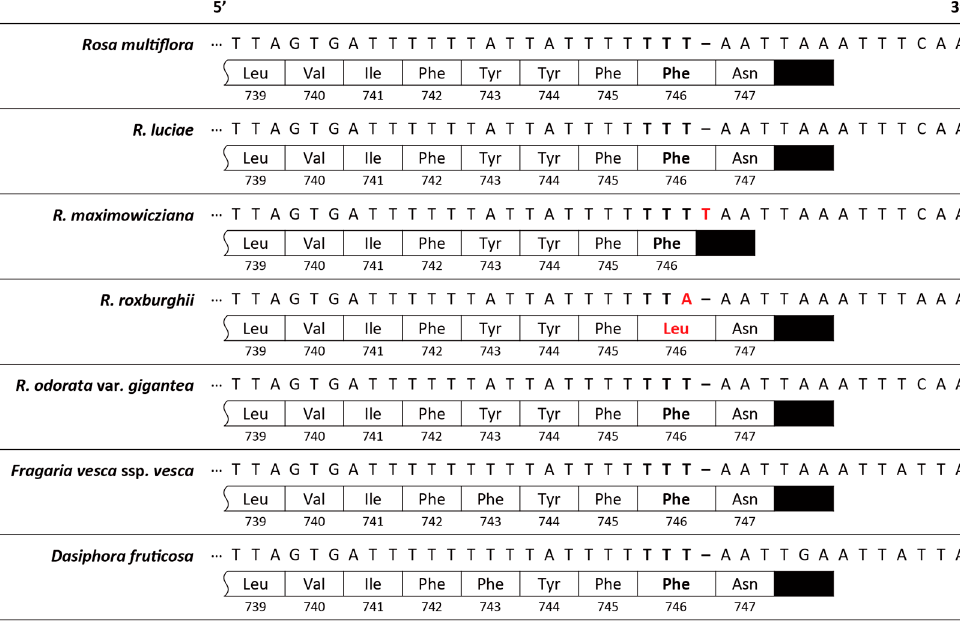
Figure 4. The 3’ region of ndhF genes of five Rosa species and two other closely related species ( Fragaria vesca ssp. vesca (GenBank accession: NC_015206; [32]) and Dasiphora fruticosa (GenBank accession: NC_036423; [33]). In each lane, aligned DNA sequence data are shown on the top. Hyphens indicate indels in the sequences. Boxed ribbons show the amino acid sequences that are coded from the DNA sequences, and black closed boxes indicate the terminal codons. Numbers under the boxes indicate the amino acid residue numbers. The mutated residues are bolded, and mutations are in red.